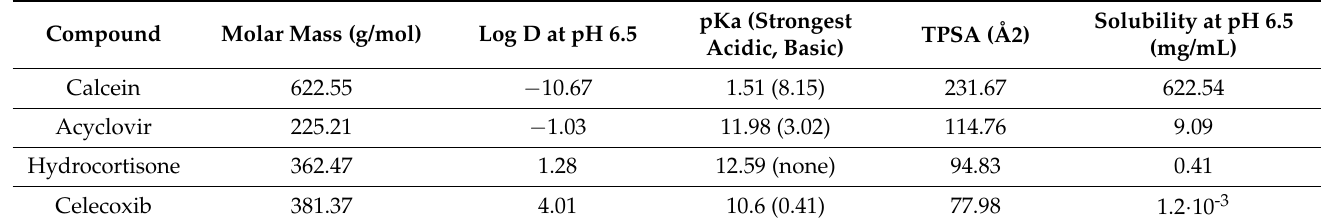
Table 1. The data are obtained from chemicalize.com, using software by ChemAxon (Budapest, Hungary).